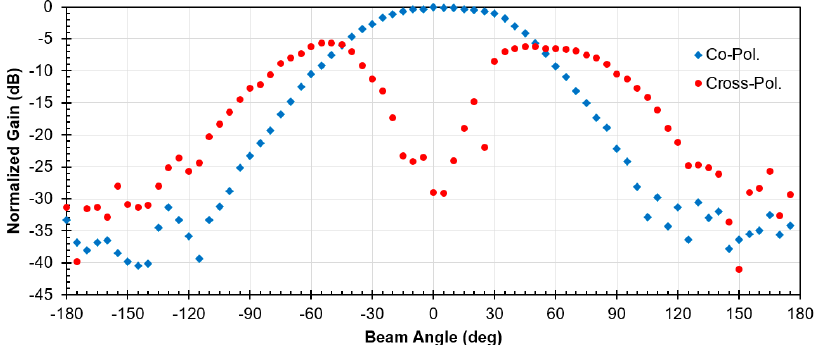
Figure 9. E-plane radiation pattern of the presented SIW LWA at 60 GHz radio frequency as the normalized gain in dB over beam angle in degrees for the co-polarization (diamonds, blue), and cross- polarization (circles,